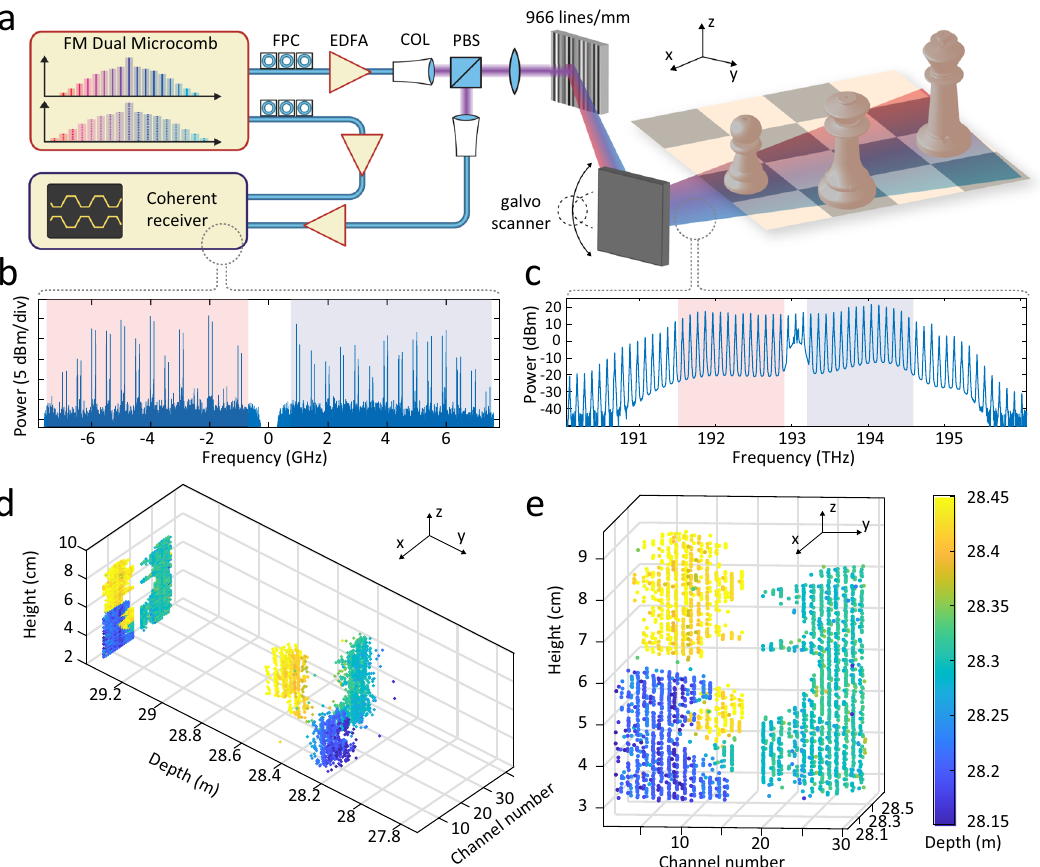
Fig. 3 Dual-comb parallel 3D imaging. a Experimental setup. The ampli fi ed signal comb is dispersed in free space by a 966 lines/mm transmission grating, and a mirror galvanometer provides vertical scanning. EDFA Erbium-doped fi ber ampli fi er, FPC Fiber polarization controller, COL collimator, PBS Polarizing beamsplitter. b Power spectral density of the electrical signal obtained at the coherent receiver highlighting 28 FMCW channels. The red and blue shading highlights signals obtained from negative and positive channel numbers. The resolution bandwidth equals to 100 kHz. Signal-to-Noise ratio ranges in between 5 – 20 dB with polarization-dependent variations. c Optical spectrum used for 3D imaging. The red and blue shaded regions correspond to the signal plotted in b . d , e Point clouds of the three chess fi gures obtained during a scan (28 × 136 points) of the mirror